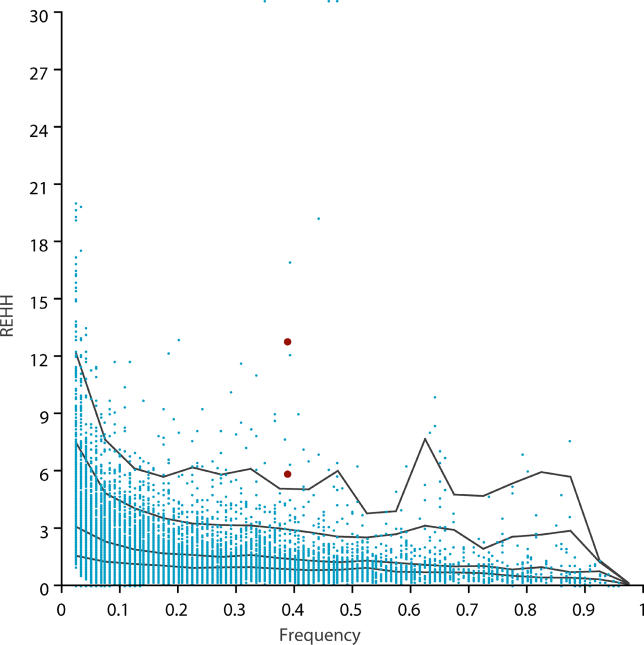
REHH × Frequency Distribution of CEU Chromosome 12REHH was calculated at 0.25 cM distances on both sides for all possible core haplotypes from CEU Chromosome 12 and represented with blue dots and given with 50th, 75th, 90th, and 95th percentiles. REHH values of CH-1 were represented with brown dots.